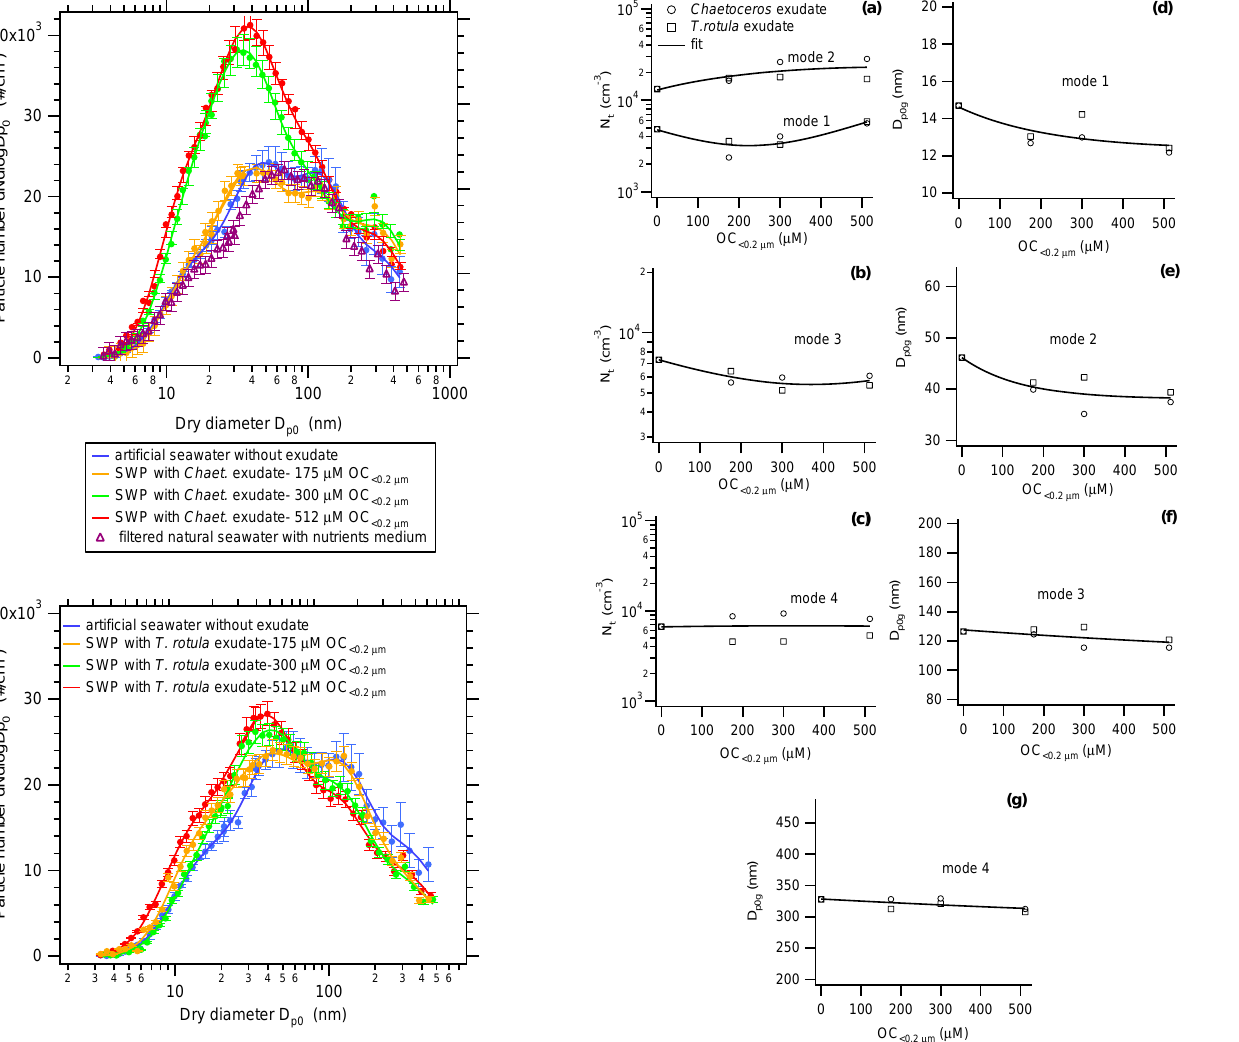
centration for all the algal exudates on study. Whereas the di- atomaceous exudate ( T. rotula and Chaet. ) size distributions are affected by the presence of organic matter with respect to the case without marine organics, no significant effects were observed for the experiments with nanoplankton exudates ( E. huxleyi and Phaeocystis ) in the range of concentrations stud- ied (see Fig. S3 in supplementary material). Regarding the experiments conducted with the monolayer method (Fig. 10, bottom), no effects were observed on the size distribution for these measurements. This could indicate that the existence of a single monolayer is not sufficient to exert any